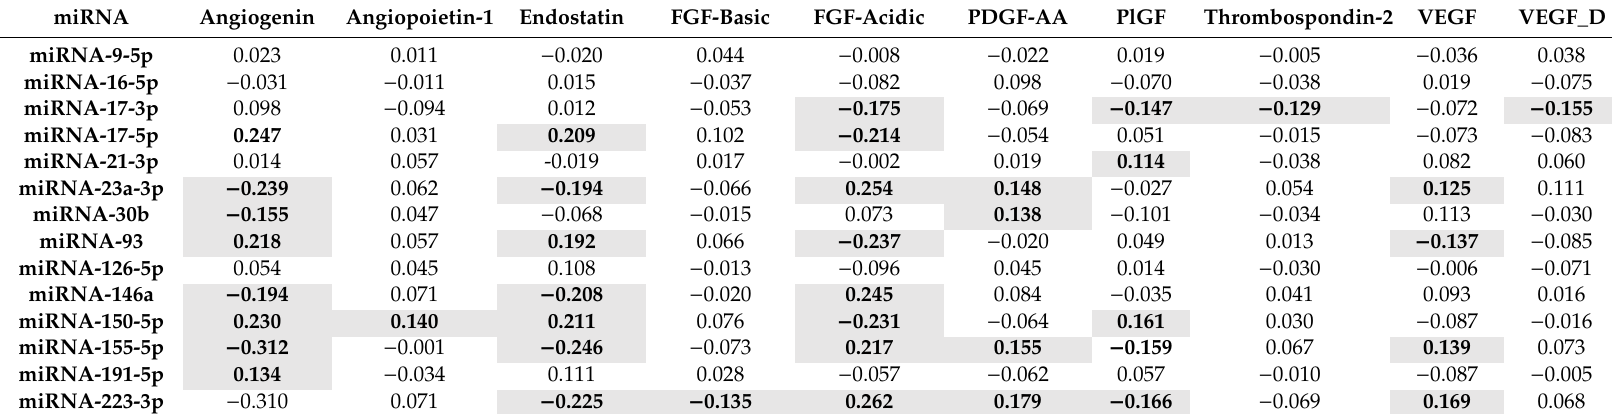
Table 4. Spearman’s correlation coe ffi cients for plasma miRNAs and angiogenesis-regulating factors in all AMD patients (both wet and dry AMD subtypes included).